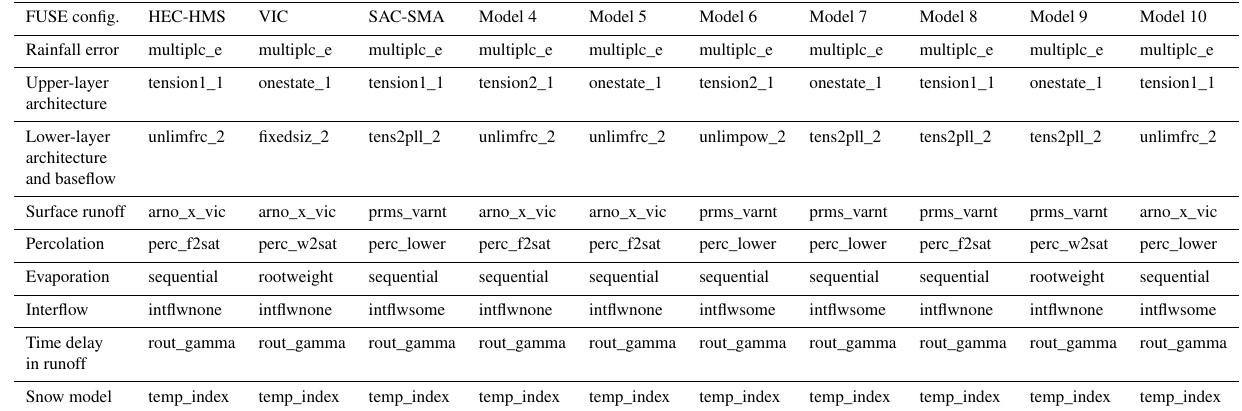
Table 1. FUSE hydrologic processes (far left column) and the various selected process representations for the 10 hydrologic models. FUSE